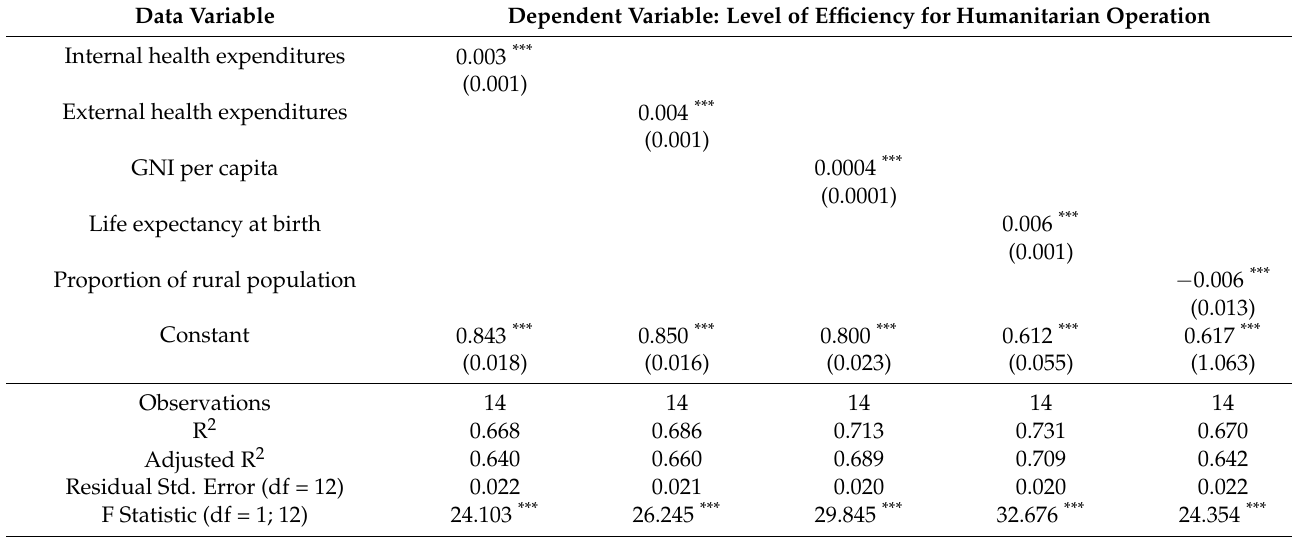
Table 12. Results of regression analyses for Malawi.